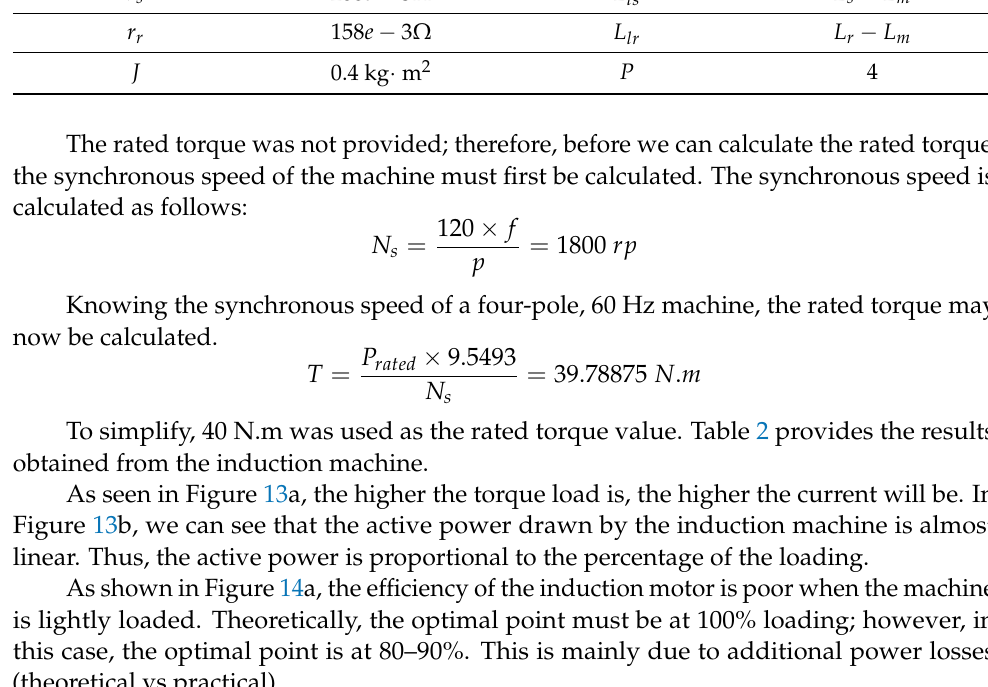
Figure 12. A static model of an induction motor.